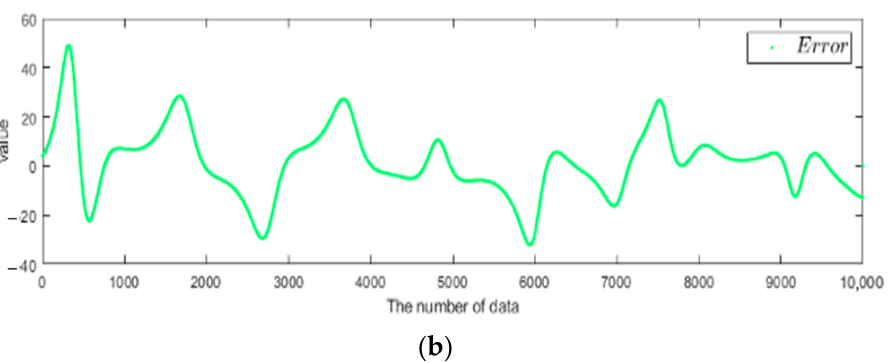
Figure 3. ( a ) Chaotic systems without a proportional-derivative (PD) controller; ( b ) The error of the chaotic systems without a PD controller.